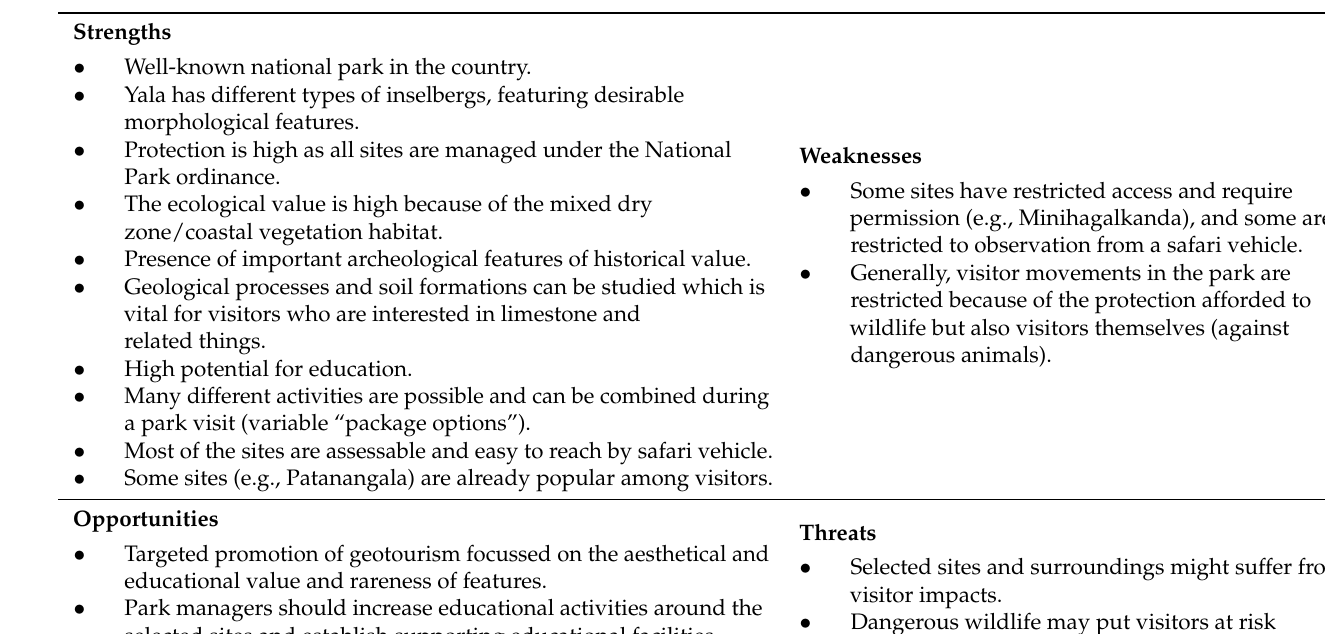
Table 4. SWOT analysis for developing geotourism at Yala National Park, Sri